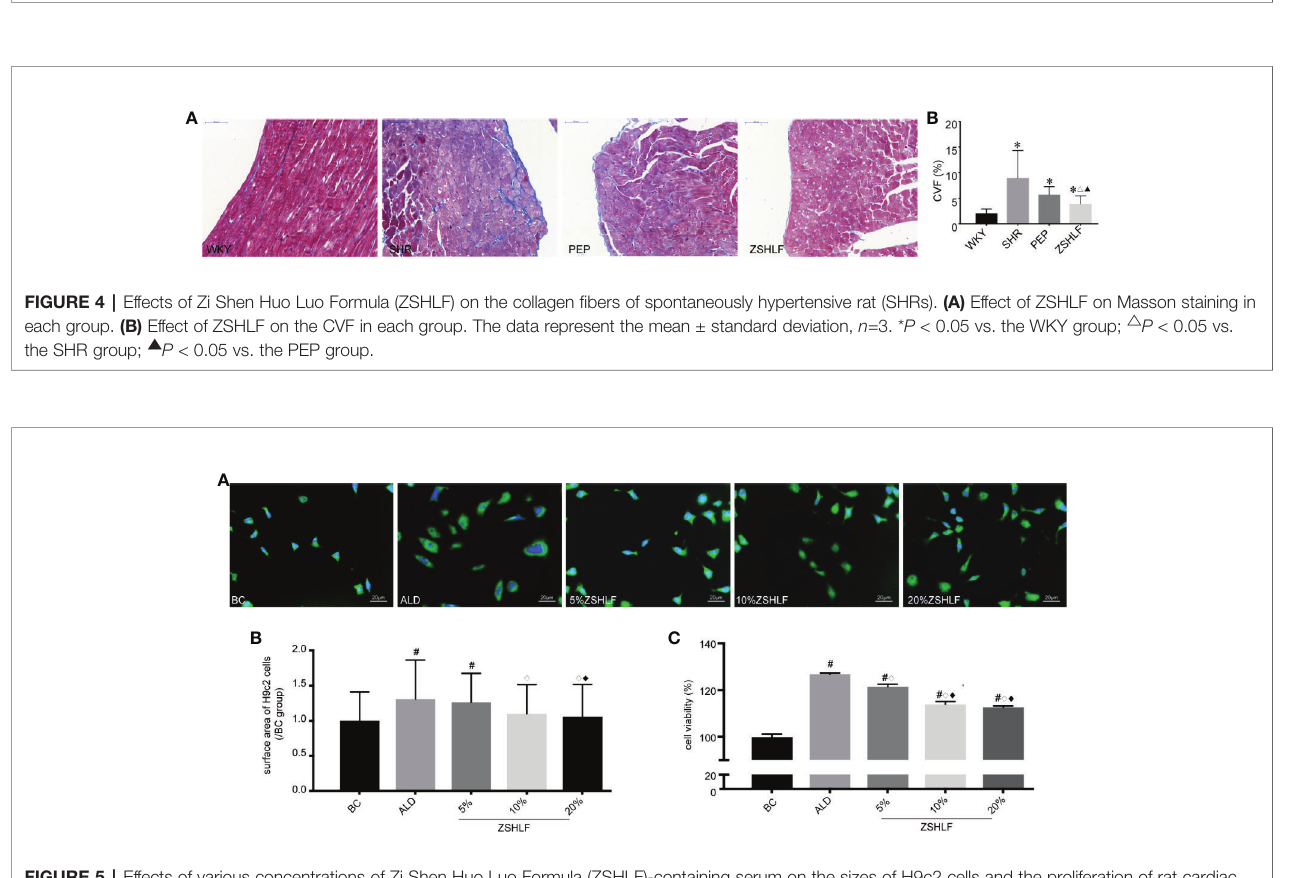
FIGURE 5 | Effects of various concentrations of Zi Shen Huo Luo Formula (ZSHLF)-containing serum on the sizes of H9c2 cells and the proliferation of rat cardiac fi broblasts (RCFs). (A) Immuno fl uorescence staining of a -actinin in cardiomyocytes in different groups at different concentrations. Immuno fl uorescence staining was observed at 400× magni fi cation. (B) Effects of ZSHLF-containing serum on cardiomyocytes surface area (10 – 15 cells per fi eld, 5 fi elds per group; the data represent the mean ± standard deviation). (C) Effects of ZSHLF-containing serum on the proliferation of cardiac fi broblasts (the data represent the mean ± standard deviation, n =3). # P < 0.05 vs. the BC group; ◇ P < 0.05 vs. the ALD group; ◆ P < 0.05 vs. the 5% ZSHLF